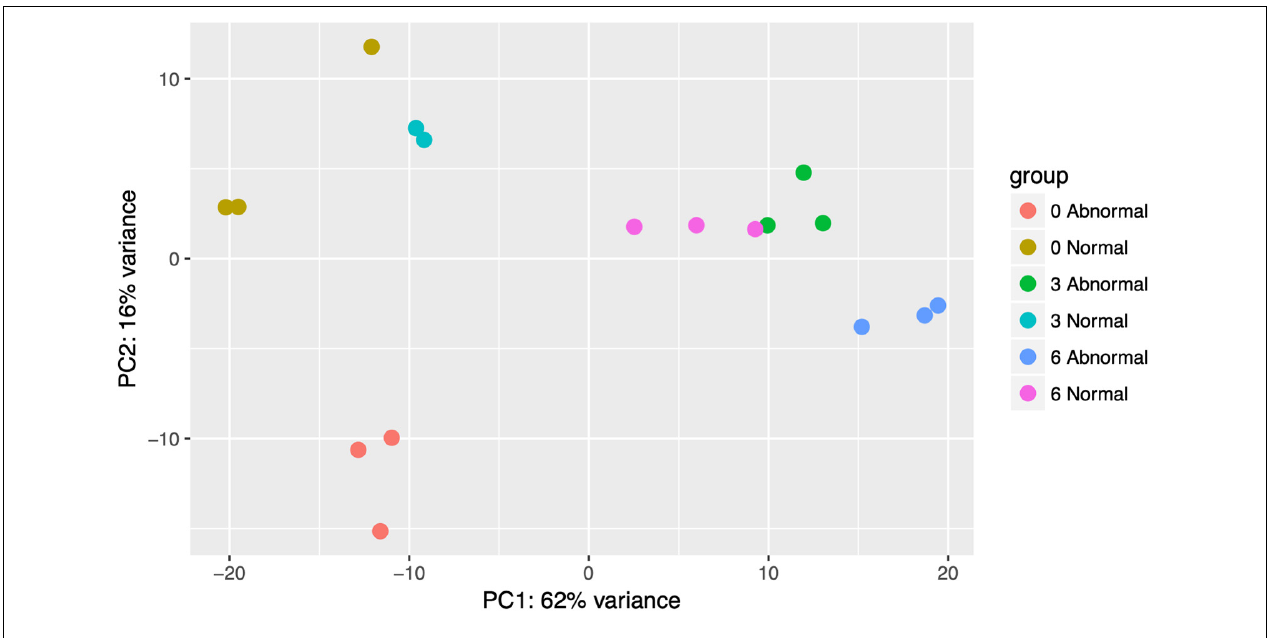
FIGURE 4 | A PCA plot was created of pooled filtered larval transcriptomes (total gene count > 40 across all samples). Point colors are unique to copper concentrations and morphologies. Counts were normalized in DESeq2 and transformed with variance stabilizing transformation (vst) prior to plotting.